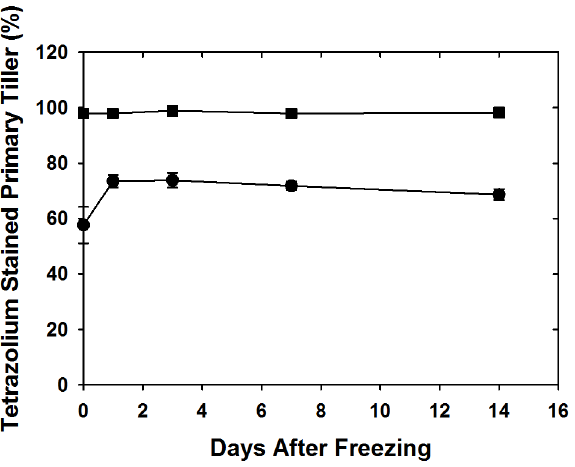
Figure 1. Changes in percent tetrazolium stained area of frozen (circles) and control (squares) crowns (primary tillers) of cold acclimated oats during 0 to 14 days of growth after imposition of freezing